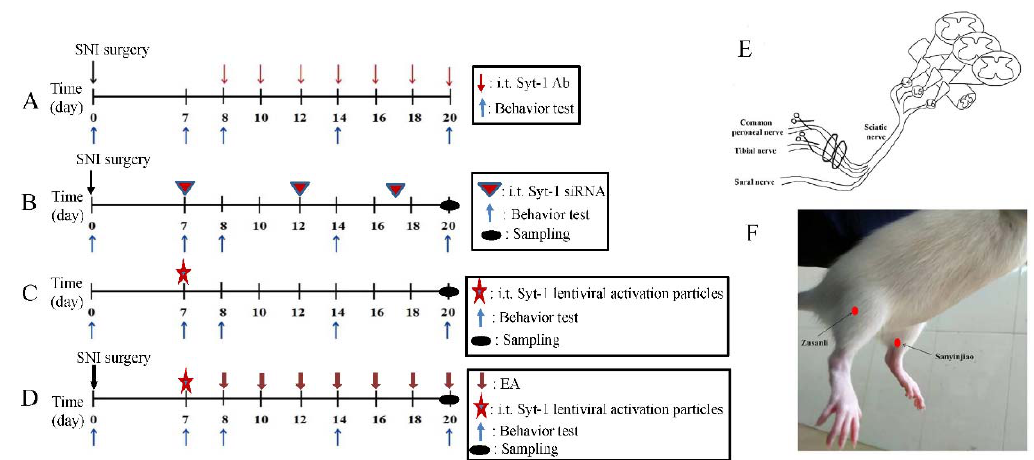
Figure 9. The schematic diagram for the experimental design. ( A ) The diagram for Syt-1 antibody intrathecal injection. ( B ) The diagram for Syt-1 siRNA intrathecal injection. ( C ) The diagram for Syt-1 lentiviral activation particles intrathecal injection. ( D ) The diagram for electroacupuncture (EA) stimulation after spared nerve injury (SNI) surgery. ( E ) The methods for the SNI model: A ligation of the common peroneal and tibial nerves was conducted with a 5.0 silk, leaving the sural nerve intact. Then, the two ligated nerves were sectioned distal to the ligation with 2–4 mm of the distal nerve stump left. ( F ) EA acupoints: Bilateral acupoints of “Zusanli” and “Sanyinjiao”. i.t. means intrathecal